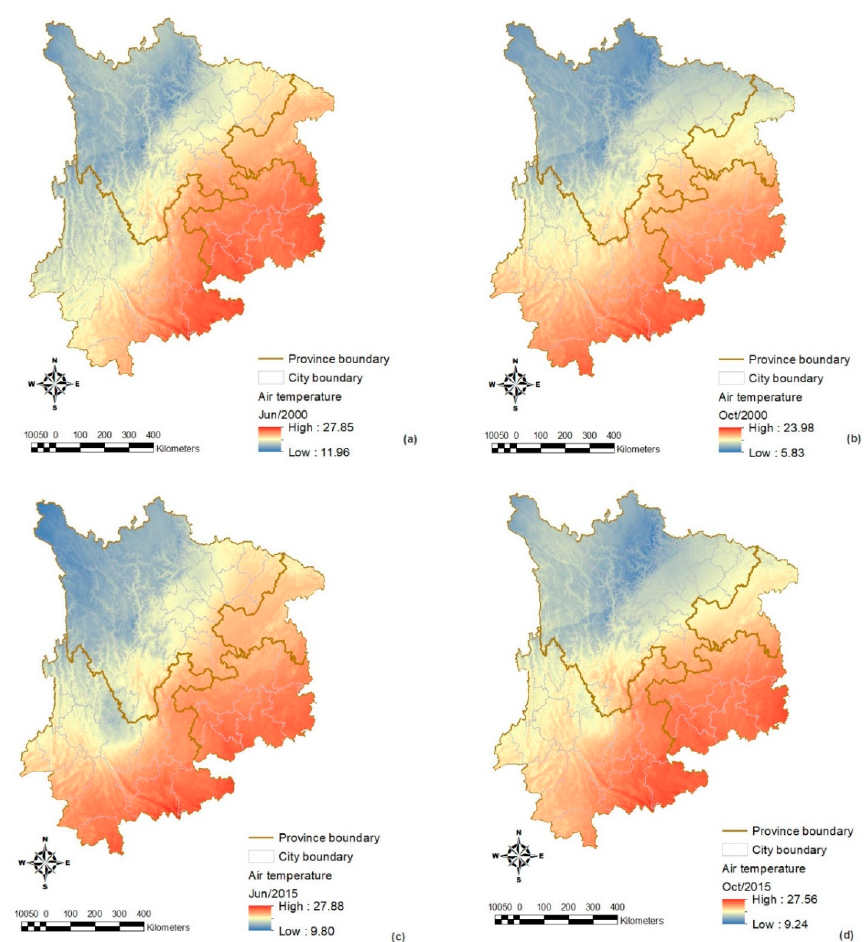
Figure 2. Spatial variation of interpolated air temperature in four months: ( a ) June 2000; ( b ) October 2000; ( c ) June 2015; and ( d ) October